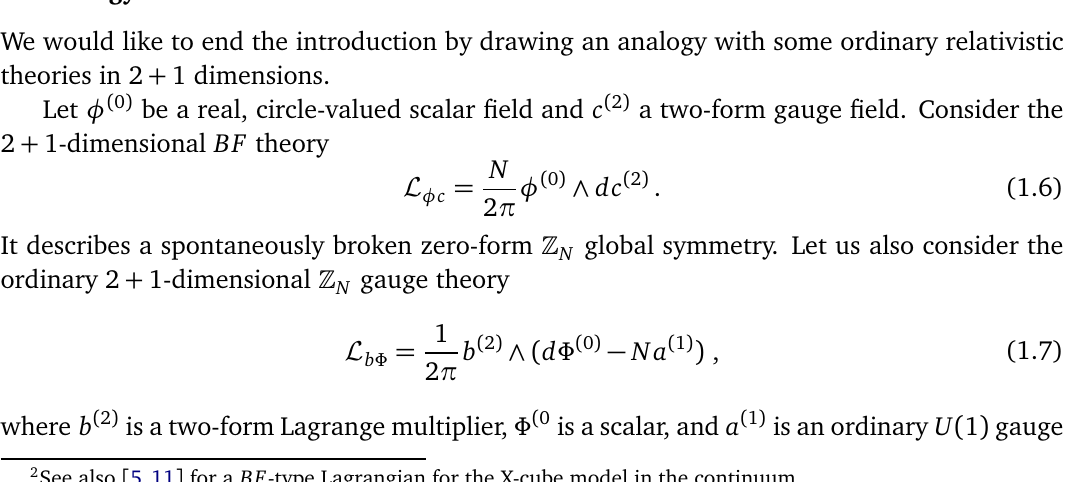
pure gauge theory